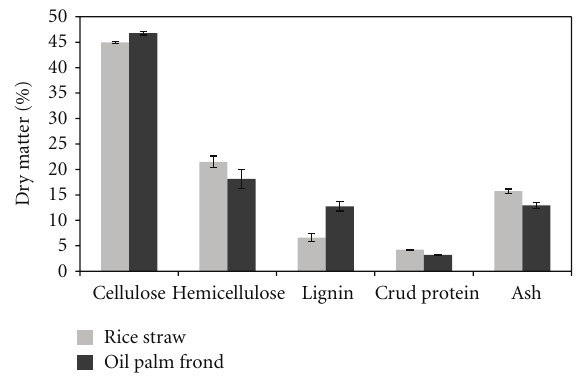
Figure 3: Lignocellulose, crude protein, and ash content of RS and OPF.